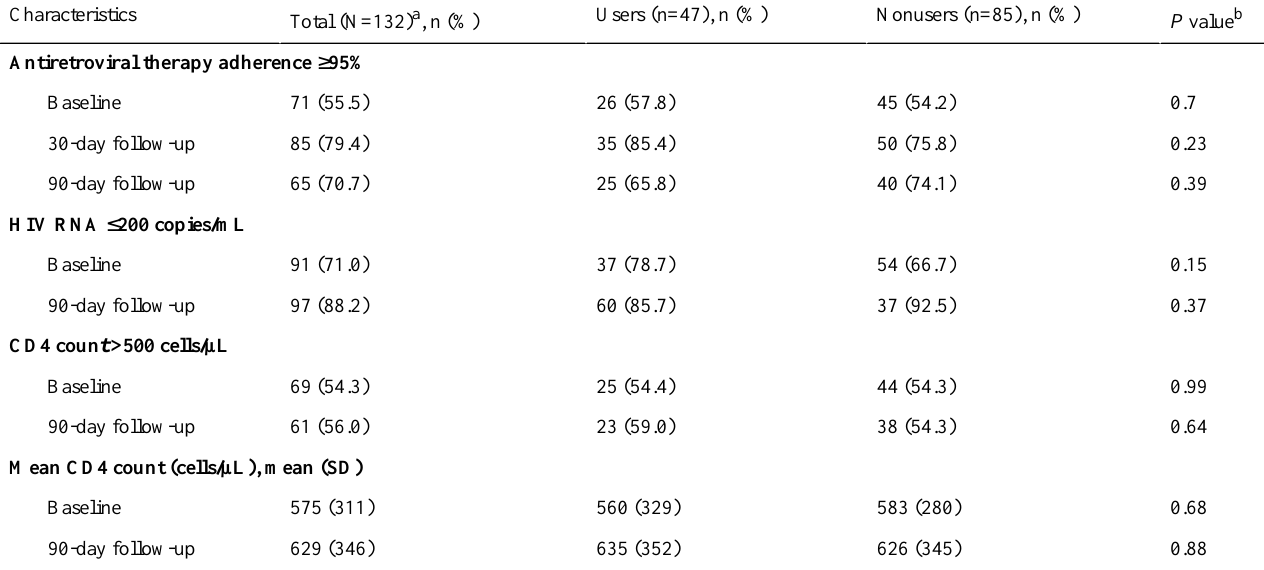
Table 1. Baseline and follow-up of antiretroviral adherence and clinical parameters of Care4Today users and nonusers, Florida Mobile Health Application Adherence Project study, 2015 to 2016